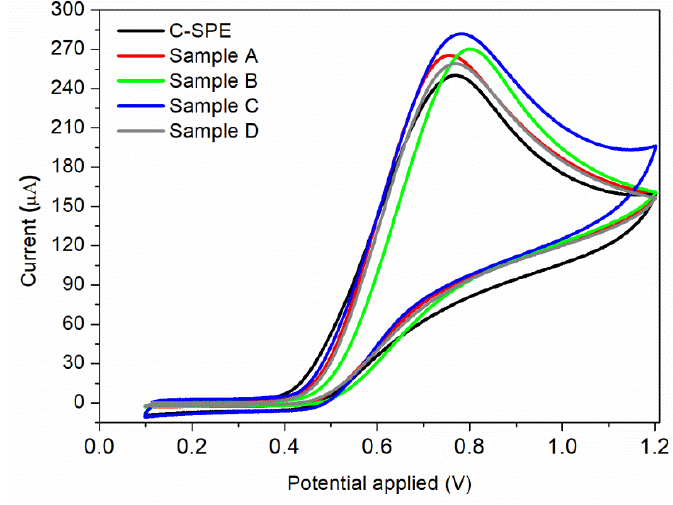
Figure 6. Cyclic voltammograms of 7 × 10 − 3 M nitrite solution using a commercial C-SPE sensor, and sensors modified by MAPLE under different conditions: Sample A; Sample B; Sample C; Sample D.